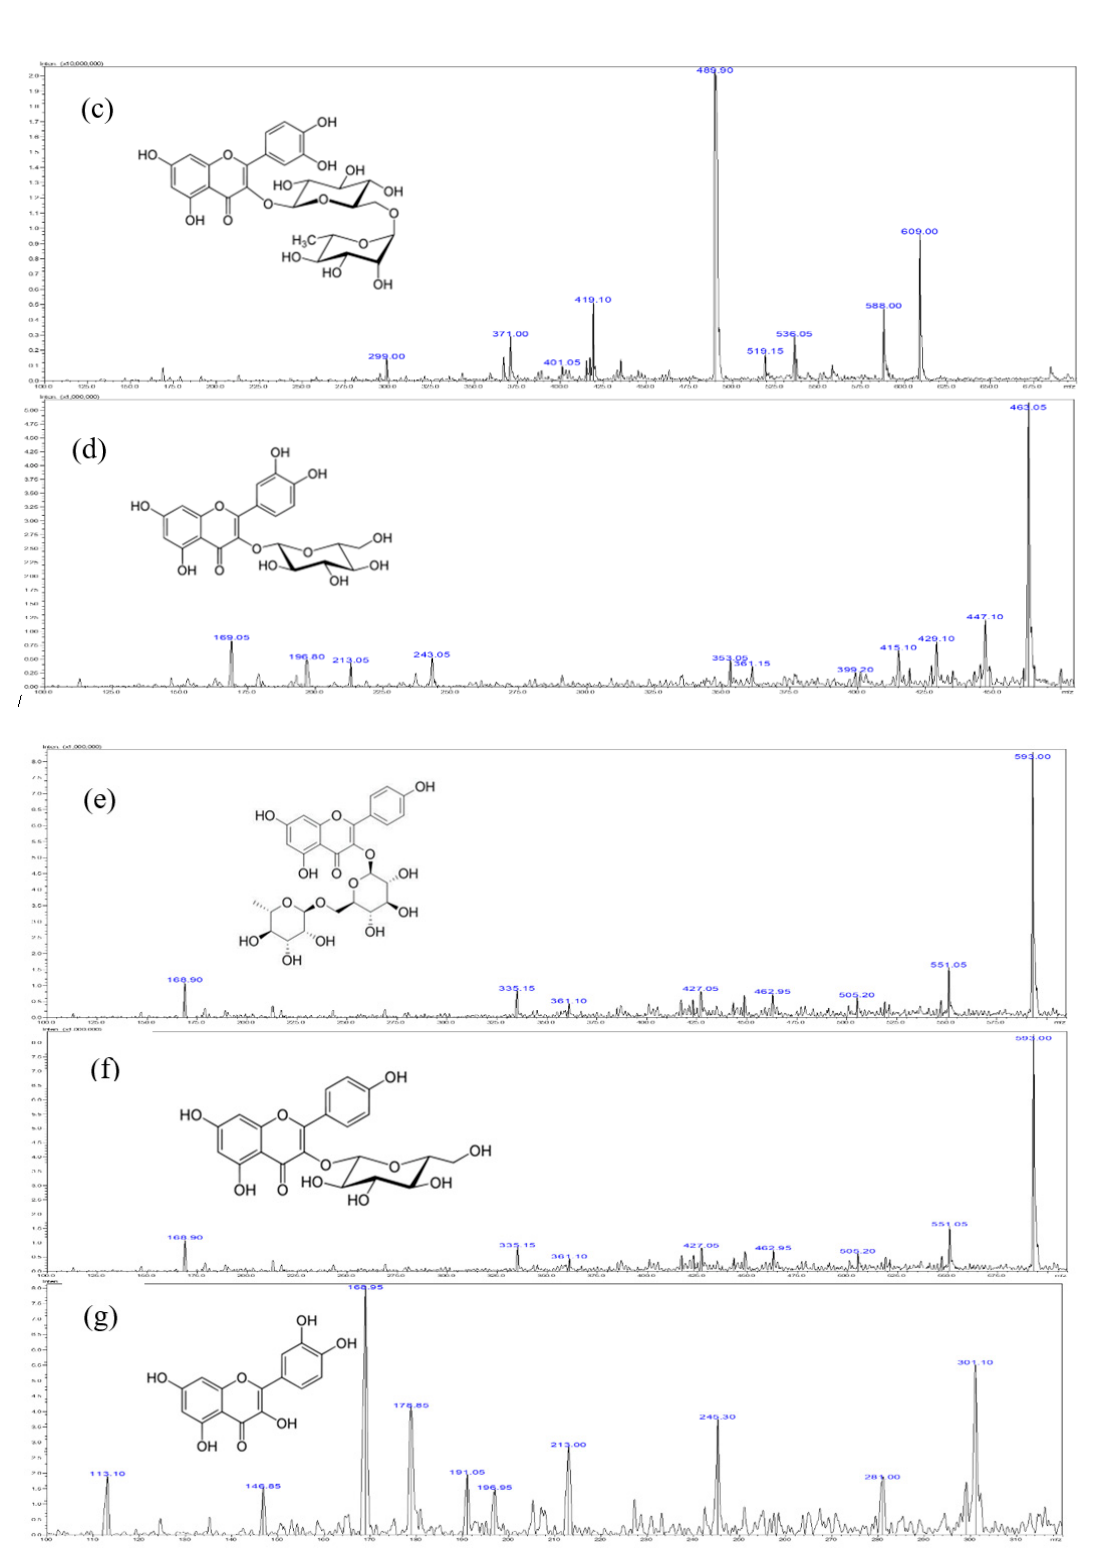
Figure 2. Typical chromatogram of Methanol extract of S. formosana . ( a ) High performance liquid chromatography diode array detection (HPLC-DAD) chromatograms obtained at 320 nm.1 = chlorogenic acid, 2 = rutin, 3 = isoquercetrin, 4 = nictoflorin, 5 = astragalin and 6 = quercetin, ( b ) mass spectrometry (MS) spectrum of chlorogenic acid, ( c ) MS spectrum of rutin, ( d ) MS spectrum of isoquercetrin, ( e ) MS spectrum of nictoflorin, ( f ) MS spectrum of astragalin, ( g ) MS spectrum of quercetin.